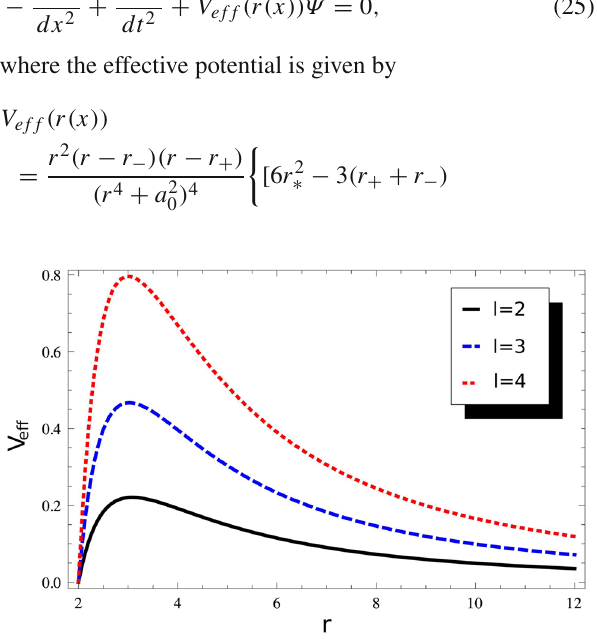
Fig. 2 The effective potential V ef f for l = 2 , 3 , 4 as a function of r